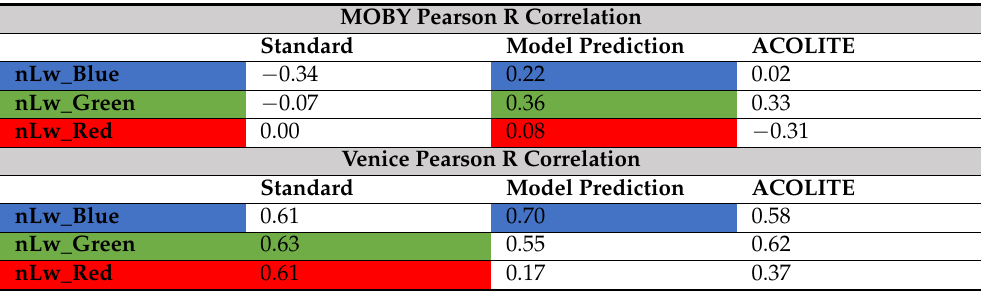
Table 4. Summary containing nLw correlation (Pearson R) and error (RMSE) for MOBY and Venice standard, model prediction, and ACOLITE atmospheric corrections. The best results per wavelength are